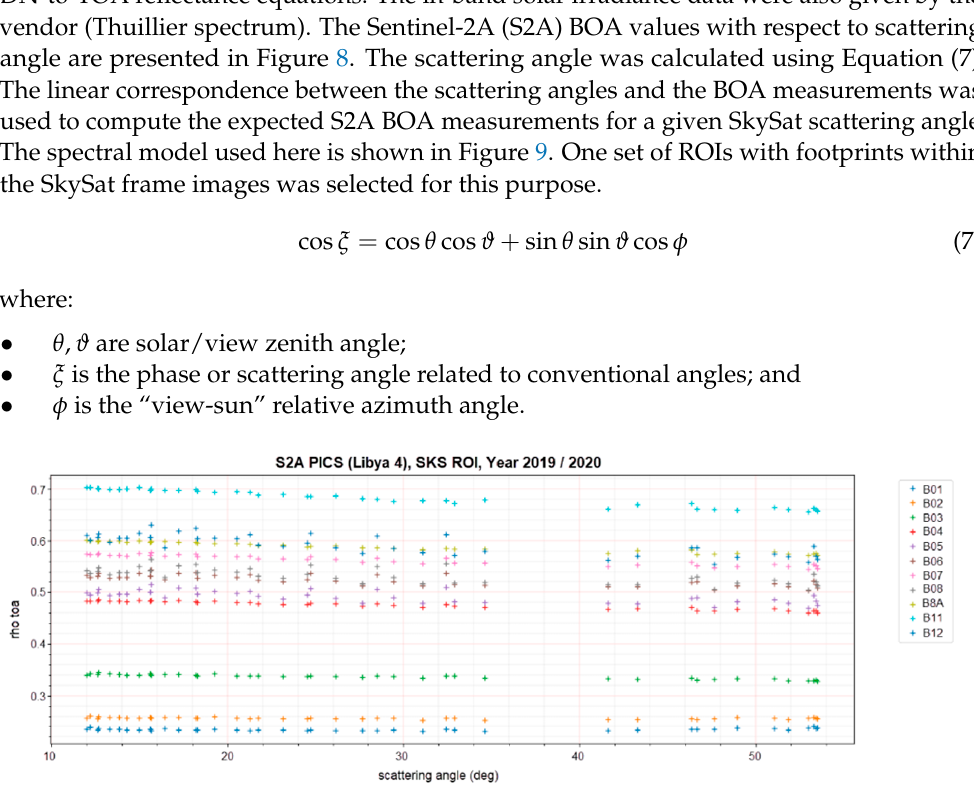
Figure 8. Input data for the BRDF modeling of Sentinel-2A time series.